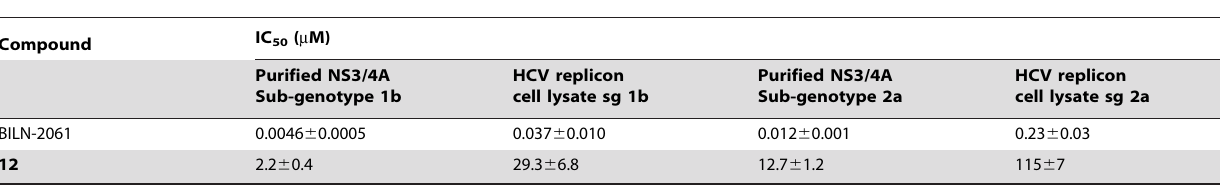
Table 4. Inhibitory activity of 12 and a control with HCV subgenomic replicon cell lysates.